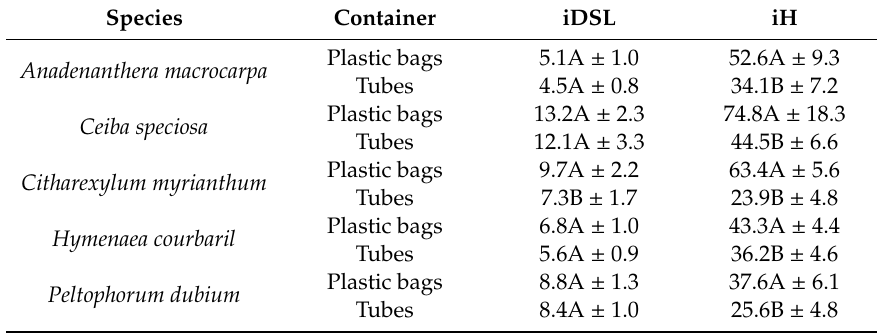
Table 1. Initial diameter at soil level (iDSL) in millimeters and height (iH) in centimeters at planting. Means with di ff erent letters between containers for each species are statistically di ff erent at 95% probability, determined by the Tukey test. ± standard deviation of the mean (n = 18).